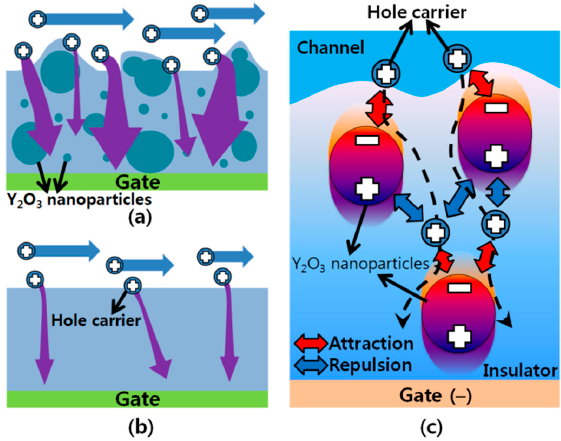
Figure 5. Leakage current paths through the ( a ) c-PVP/Y 2 O 3 composite and ( b ) c-PVP gate insulators. ( c ) Possible interaction between the holes and the Y 2 O 3 nanoparticles in the c-PVP/Y 2 O 3 composite insulator.